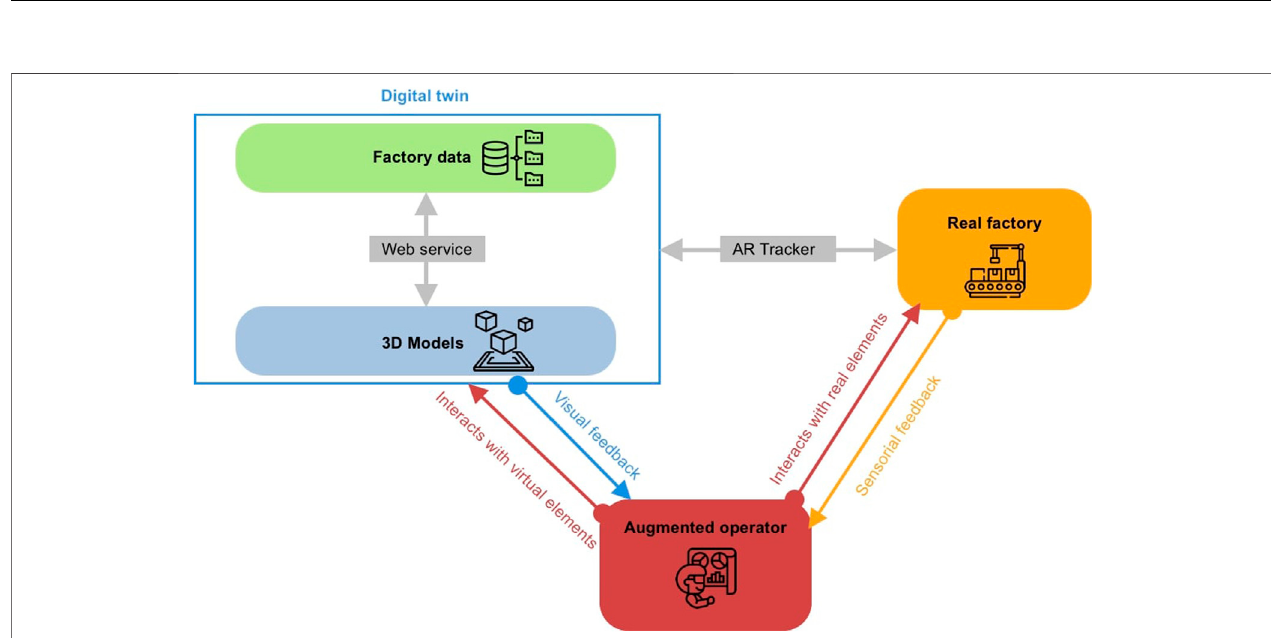
FIGURE 5 | Architecture of our model: Integration of the augmented operator within the relationship between the Digital and Physical Twin and their bi-directional relationship.